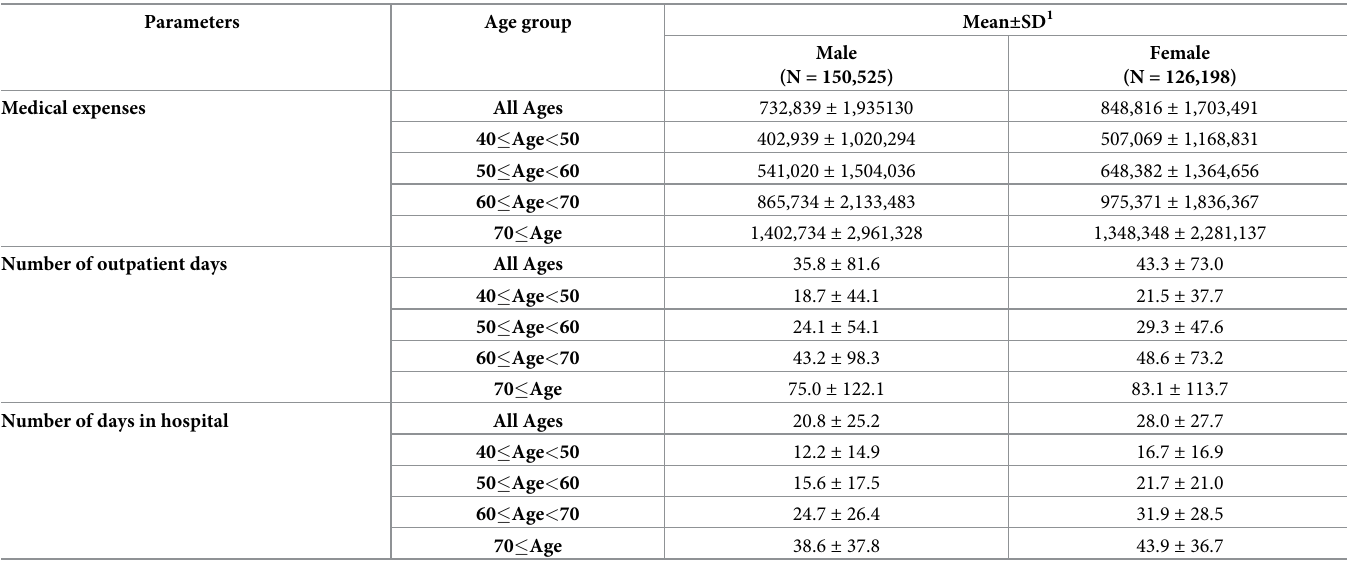
Table 3. Medical expenses and medical care use by gender and age group.